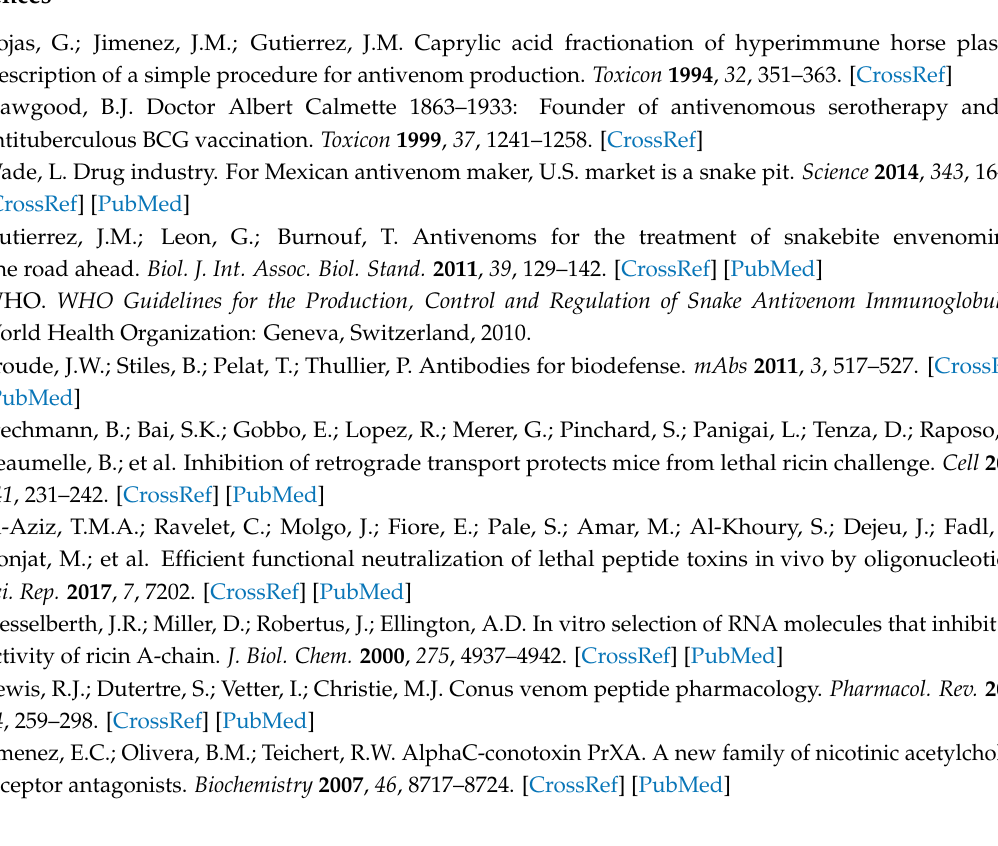
Figure S1: α C-conotoxin PrXA-induced lethality, Figure S2: histogram distribution of TE671 cell capacitance, Figure S3: Lack of effect of the aptamers on the ACh response in TE671 cells. Author Contributions: G.T.S. performed in vivo experiments, J.M., S.N. and S.D.W. performed cell culture, patch clamp and pharmacological experiments. E.F., C.R., T.M.A.E. M.R. and E.P. conducted aptamer selections